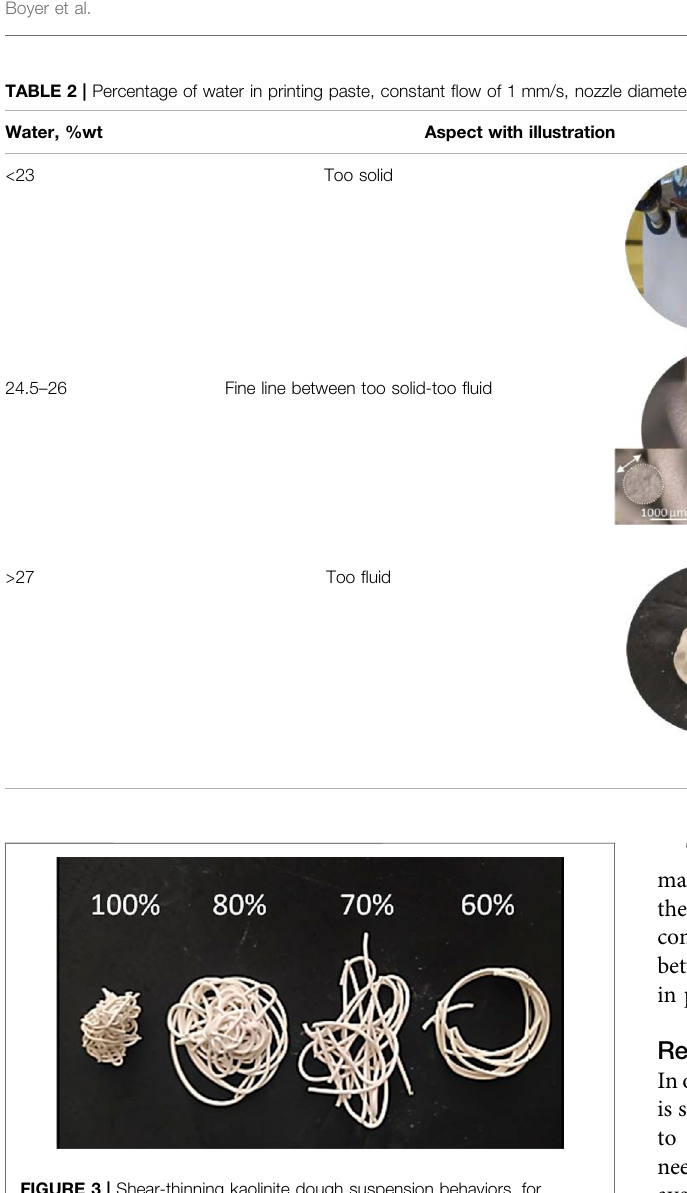
Frontiers in Materials |